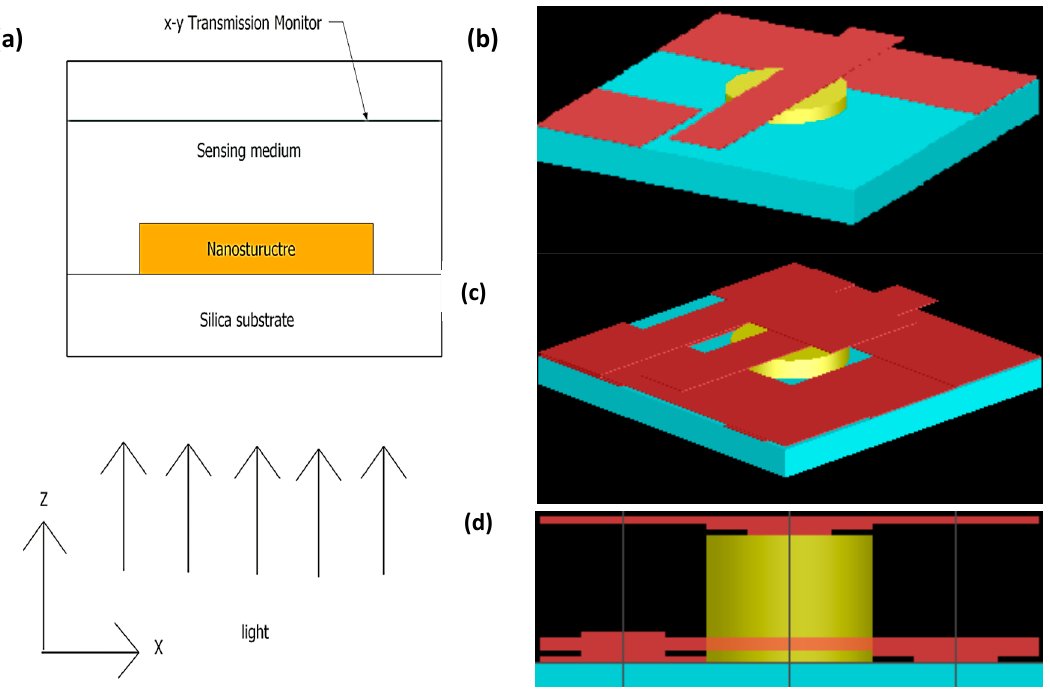
Figure 1. Schematic representation of the simulation model ( a ), 3D view (3 G flakes) ( b ), 3D view (10 G flakes) ( c ), and cross section view ( d ) of the gold nano-disk (ND)-graphene (G) flakes hybrid nanostructure.